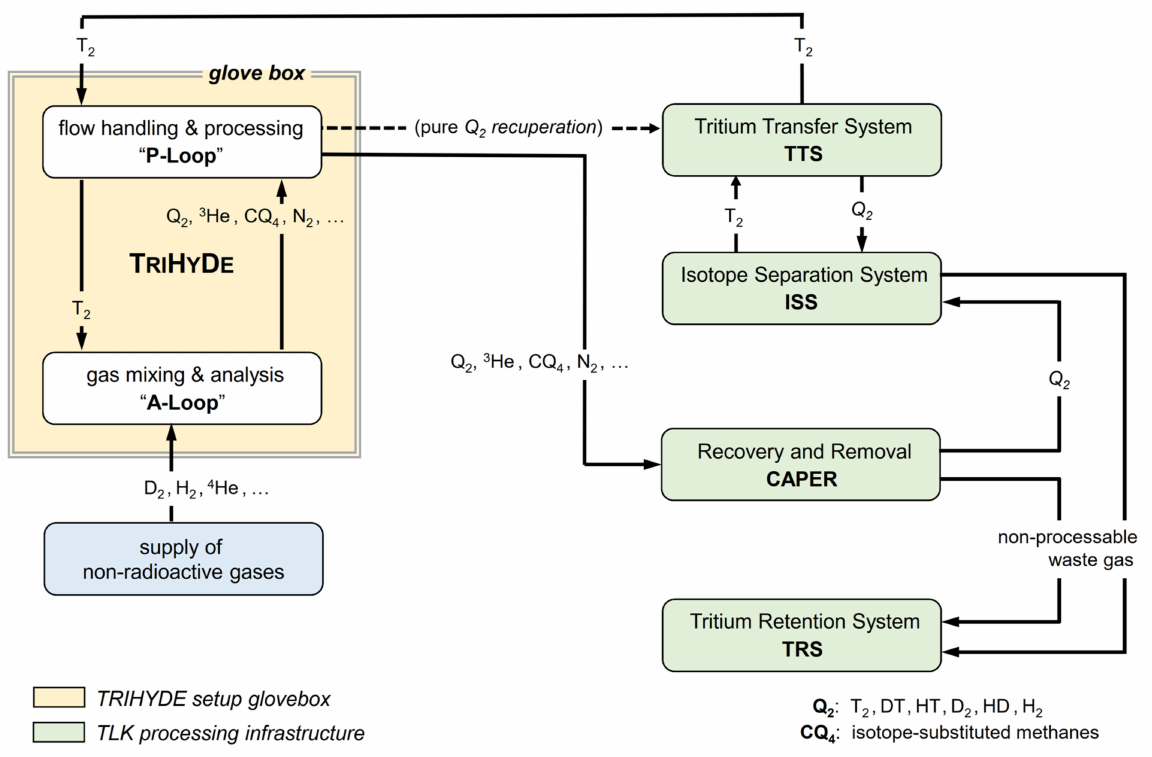
Figure 2. Schematic overview of TRIHYDE and its integration into the TLK infrastructure. TRIHYDE consists of two linked loops for gas mixing and analysis (the A-Loop) and for flow handling/processing of gas mixtures (the P-Loop). Note that CQ 4 stands for all isotope-substituted methanes, with Q = H, D, T. For details, see